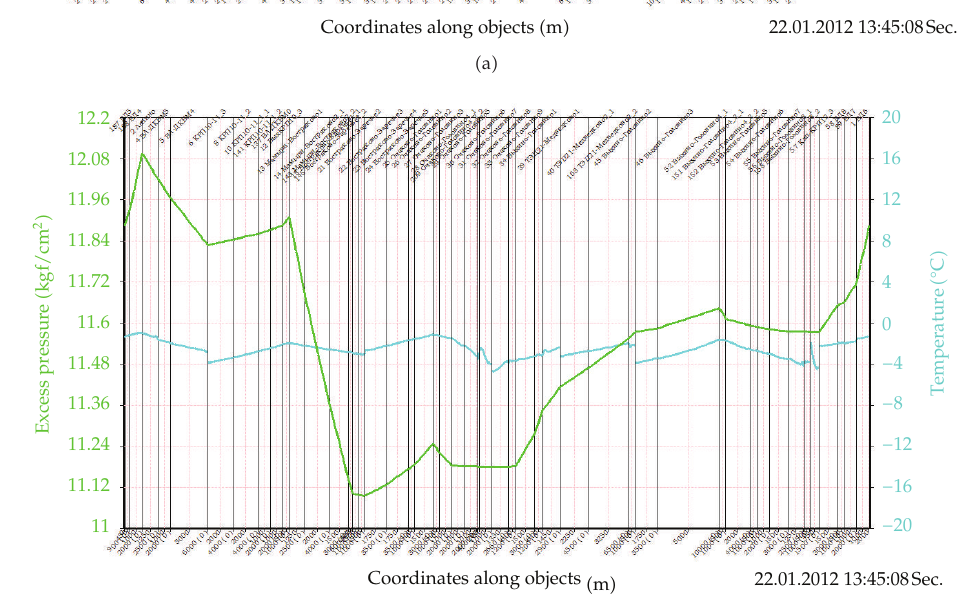
Figure 7: Example of space distributions “pressure-volumetric flow rate” (cid:6) a (cid:7) and “pressure-temperature” (cid:6) b (cid:7) along the length of MGR circular segment (cid:6) temporal section (cid:7) .